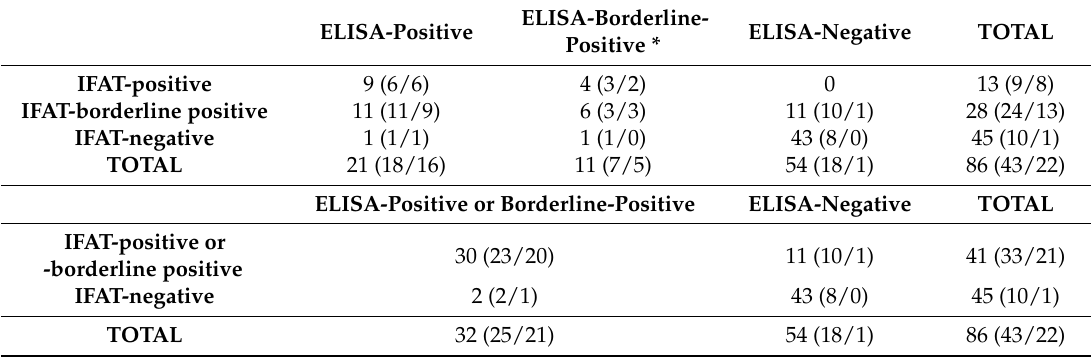
Table 2. Results from enzyme-linked immunosorbent assay (ELISA) and immunofluorescence antibody test (IFAT) screening of the 86 serum samples tested in the study. The numbers in parentheses indicate the total number of samples tested by Western blot (WB)/number of samples listed as positive by